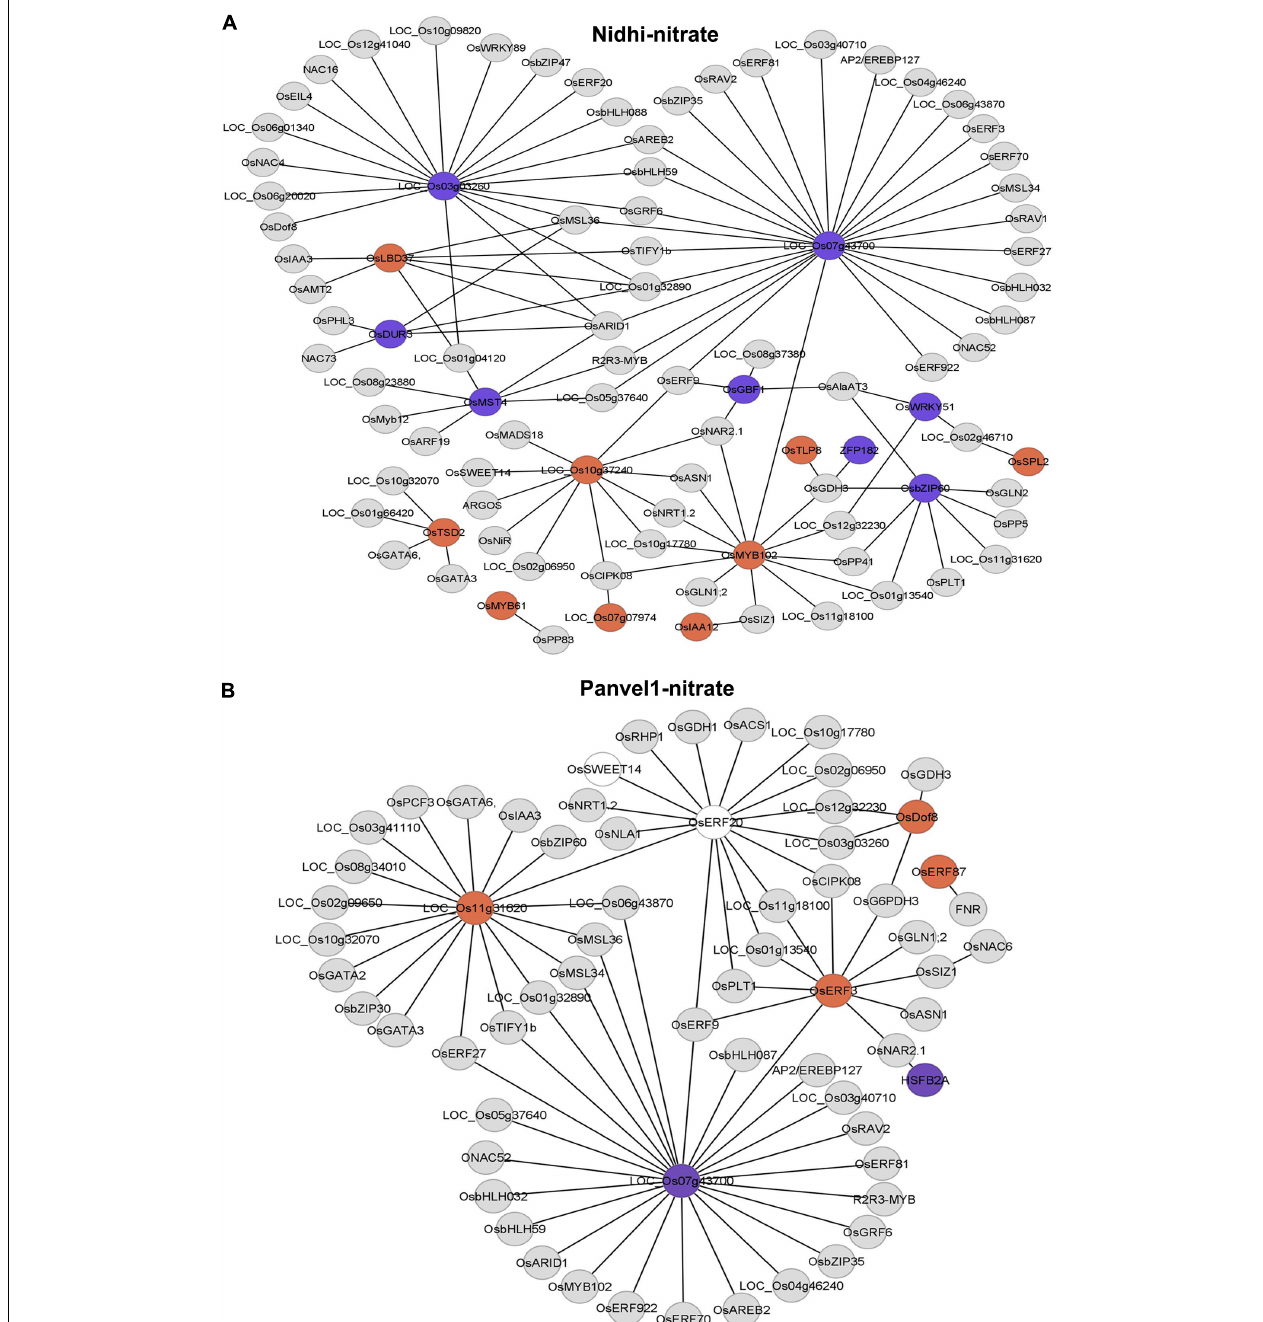
FIGURE 5 | Predicated nitrate-responsive transcriptional regulatory network (TRN) in Nidhi (A) and Panvel1 (B) . Nitrate-regulated Arabidopsis TRNs (Gaudinier et al., 2018) were used to identify the DEGs-associated interactors in rice. Orthologous information was retrieved from the PlantGDB database and networks were constructed in Cytoscape ver 3.9.0. Expression values of DEGs were mapped onto the networks where red color nodes represent upregulated DEGs and blue color nodes correspond to downregulated DEGs. Light gray color nodes represent interactors but not DEGs in Nidhi and Panvel1.